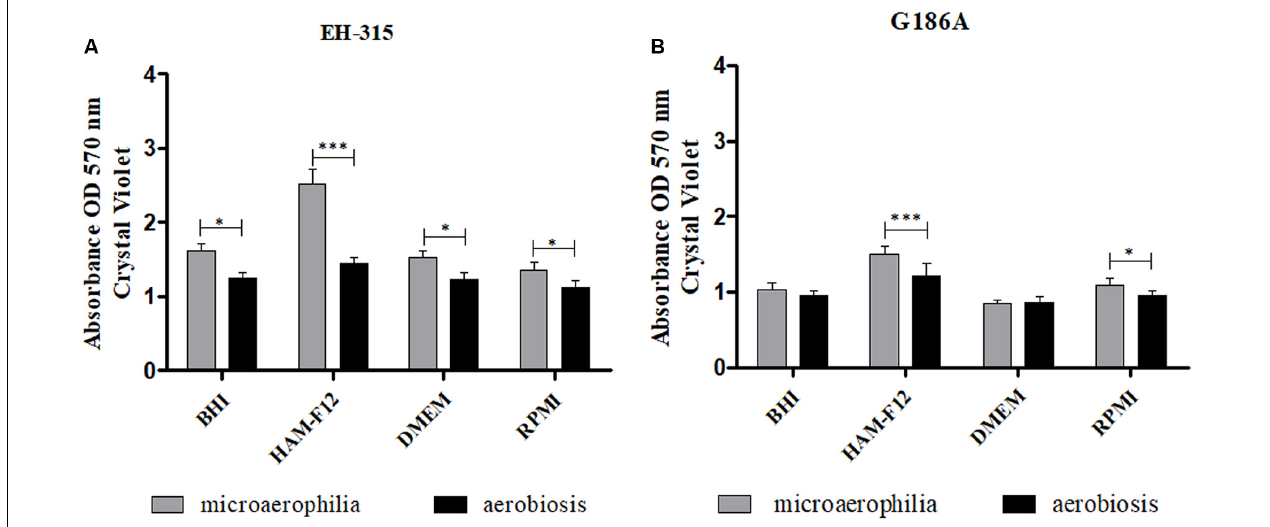
FIGURE 4 | Comparison between the biomasses formed by the strains H. capsulatum EH-315 (A) and G186A (B) in different culture media and under different oxygen atmospheres. * p < 0.05, ** p < 0.01, and *** p < 0.0001.